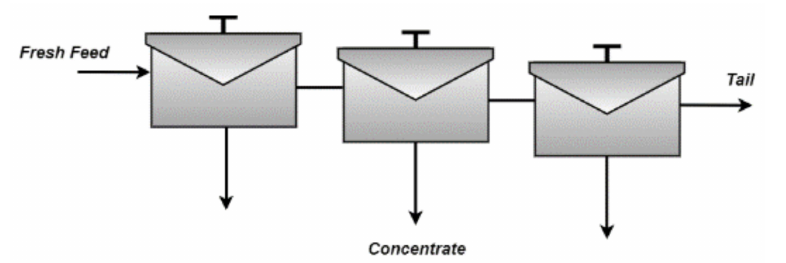
Figure 6. Schematic representation of a cell bank. Table 4. Input variables from the cell bank